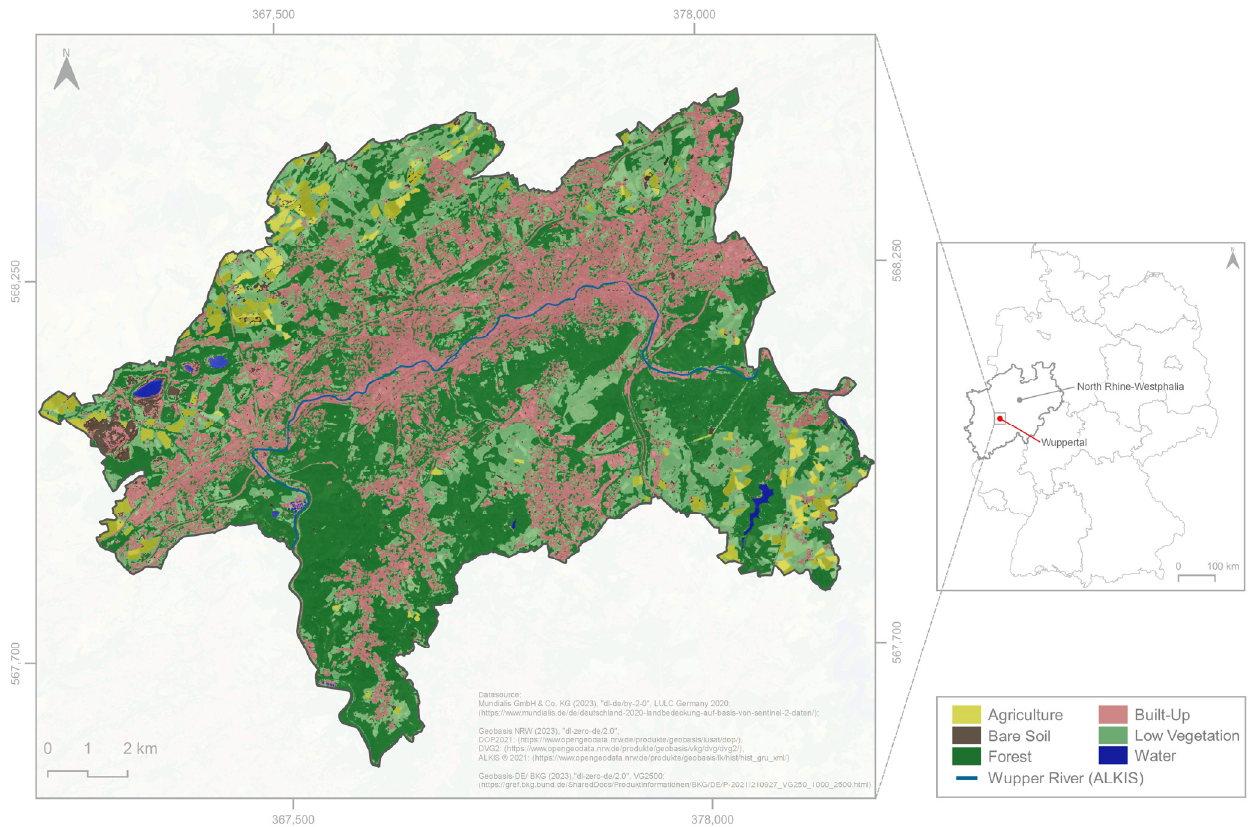
Figure 1. The study area of Wuppertal is located in the federal state of North Rhine-Westphalia (NRW), Germany. The background map describes the land use/land cover of Wuppertal in 2020 based on the Sentinel-2 classification product of the government-funded INCORA project [10,42]. The original data source was colour-modified and overlaid with the Wupper river using ALKIS data.